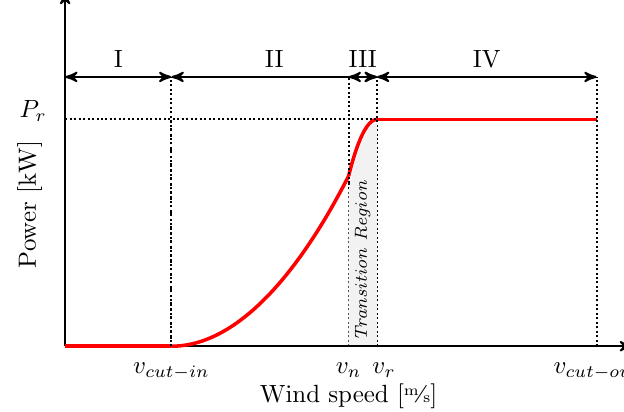
Figure 3. Wind turbine power curve and operational